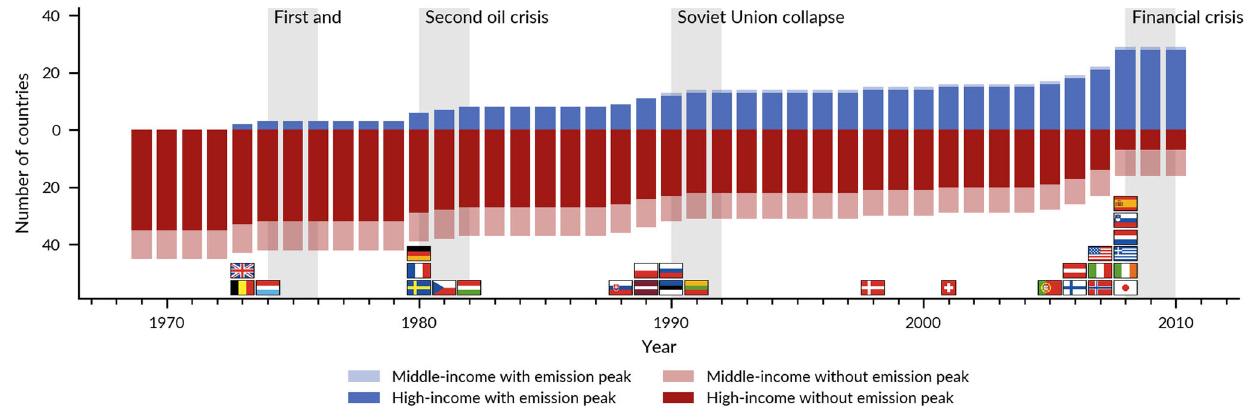
Fig. 2 Emissions peaks and economic crises. Number of countries that have and have not peaked CO 2 emissions (the year with the highest rolling average of the fi ve past years). OECD and G20 countries. The fl ag indicates the peak year of the respective country. Flags designed by OpenMoji. Source: 31